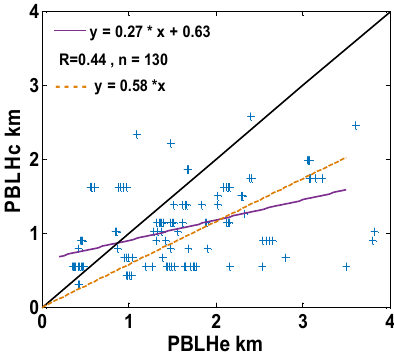
Figure 11. Comparison of PBLHe and PBLHc for the Beijing area in 2015.